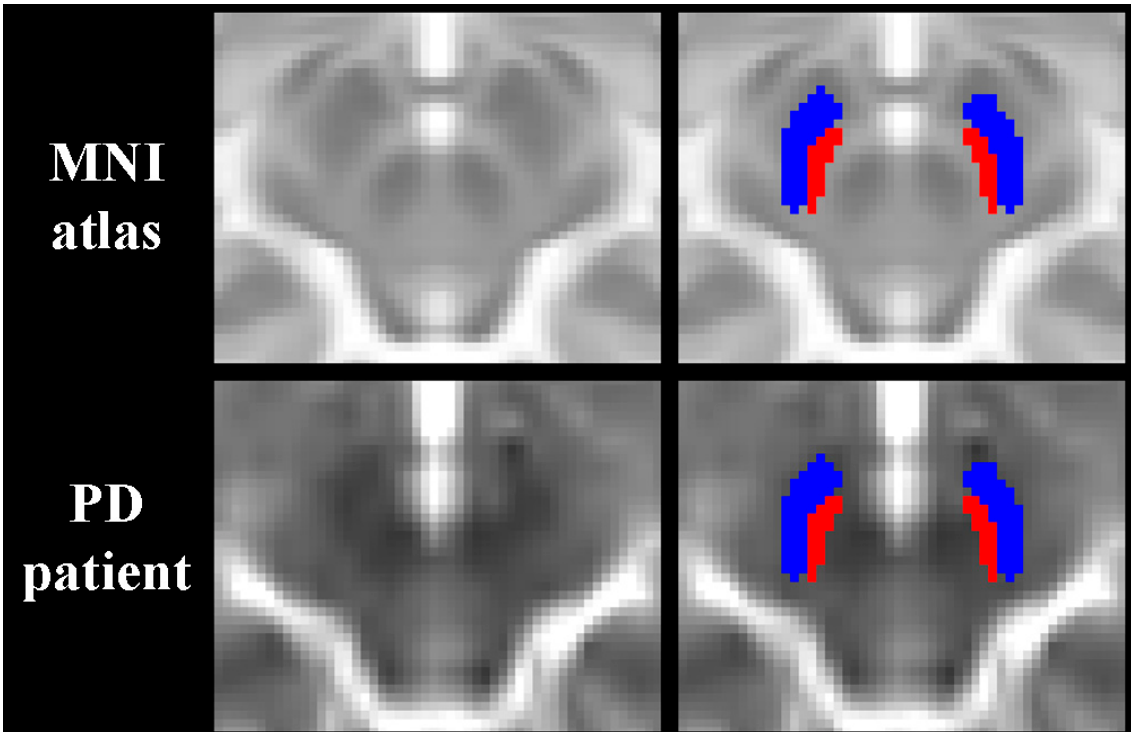
Figure 1. Standard space-defined regions of interest for the substantia nigra. The top row shows the standard space-defined masks of the substantia nigra, with the reticulata colored in blue and the pars compacta colored in red. The bottom row depicts a b = 0 image after spatial normalization to the Montreal Neuroimaging Institute (MNI) atlas in a representative Parkinson’s disease patient.